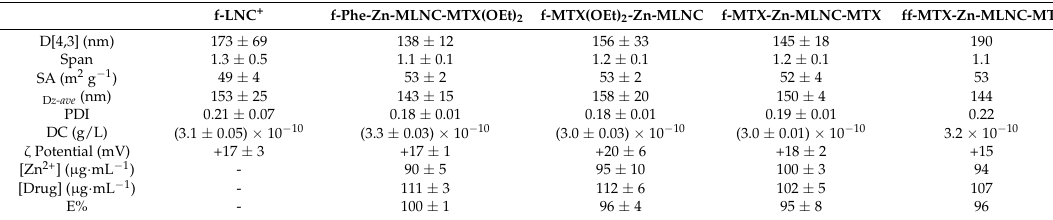
Physicochemical characterization of fluorescent-labeled formulations, f -LNC + , f